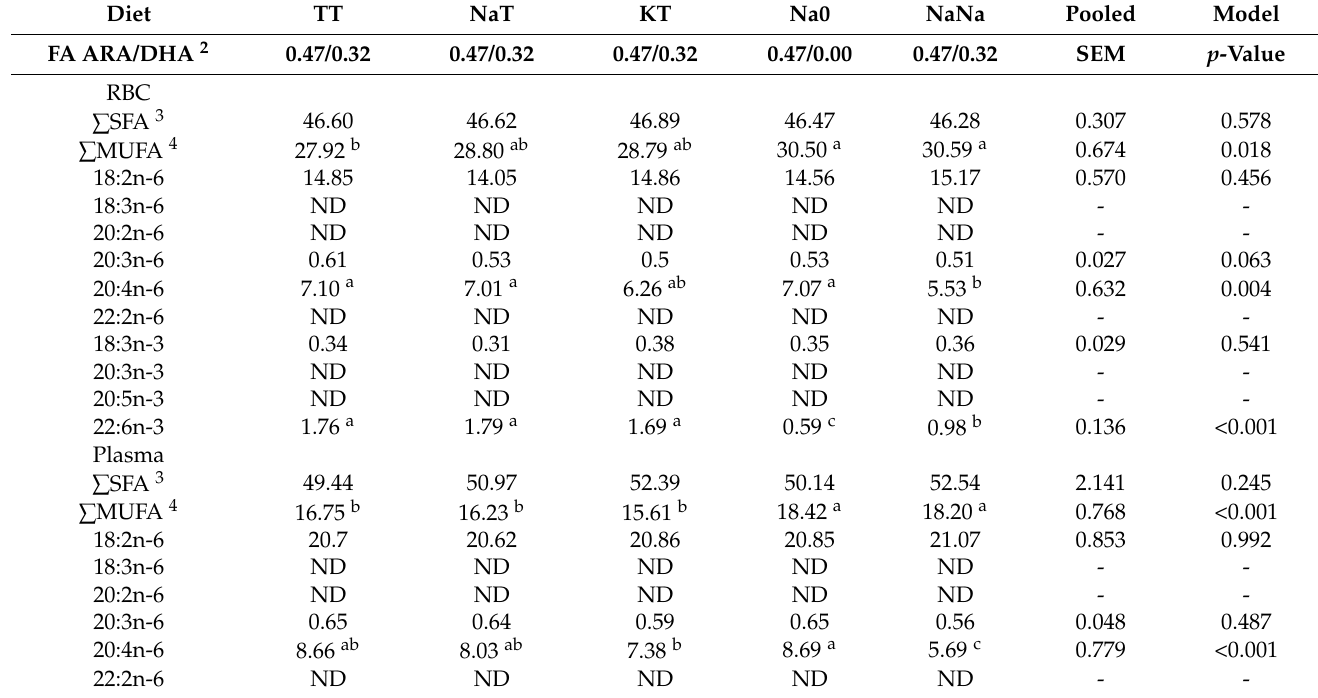
Table 6. Select RBC and plasma FA concentrations of pigs receiving experimental milk replacers with different sources of ARA (% of total measured FA) 1